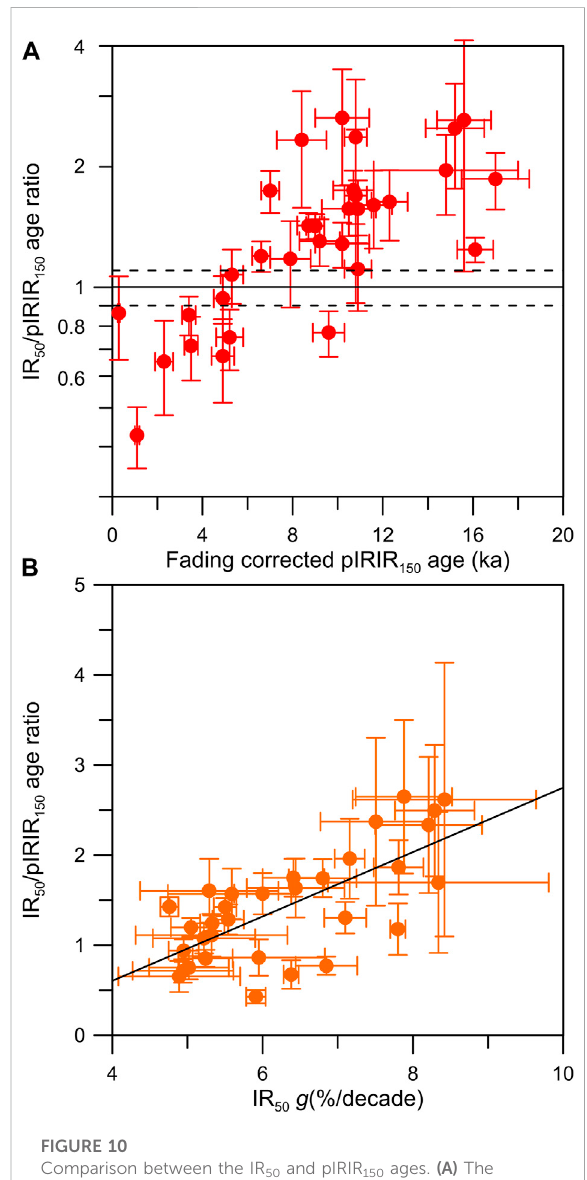
FIGURE 10 Comparison between the IR 50 and pIRIR 150 ages. (A) The relationship between the IR 50 /pIRIR 150 age ratio and the fading corrected pIRIR 150 ages. The IR 50 and pIRIR 150 ages used for calculating the age ratios are fading corrected following Lamothe et al. (2003). (B) Relationship between the IR 50 /pIRIR 150 age ratio and g values for the IR 50 signal with the trendline (black solid